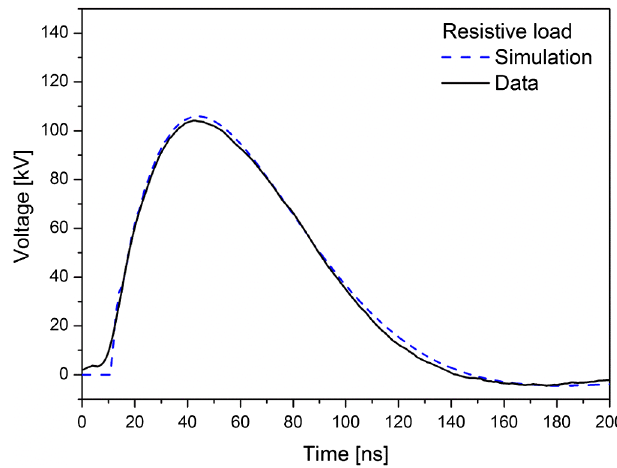
FIG. 4. Comparison of experimental data and simulation ( LSP ) results for a test of a single LTD cavity with a 0 . 6 Ω resistive load.